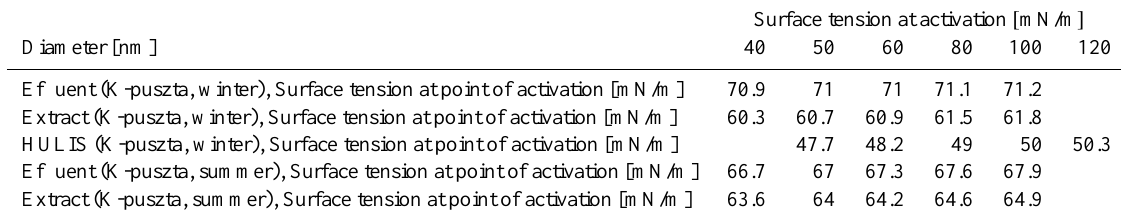
Table 5. Surface tensions at the point of activation according to the ρ ion model for the K-puszta winter sample.